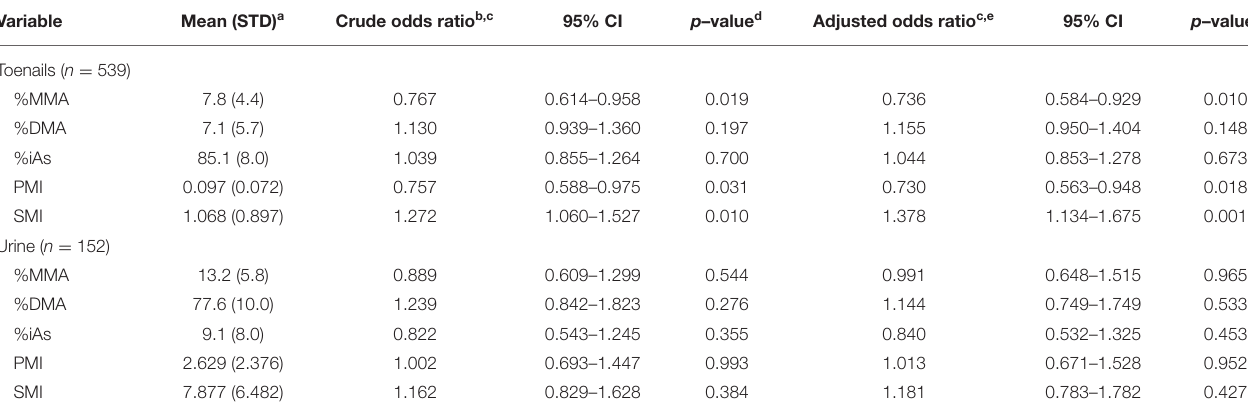
TABLE 3 | Association between prostate cancer and arsenic speciation measures in toenail and urine samples. Variable Toenails ( n =